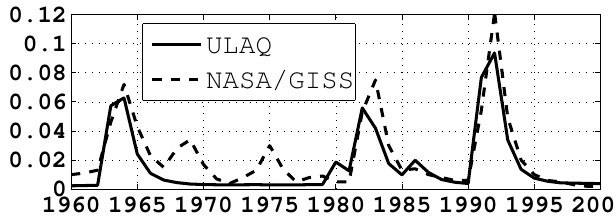
Figure 1. ULAQ-CCM-calculated time series of the global annual mean stratospheric aerosol optical depth at λ = 0.55 µ m (solid line), as an average from the VE simulations. As a comparison, the NASA/ GISS values are superimposed (http://data.giss.nasa.gov/modelforce/strataer; dashed line)